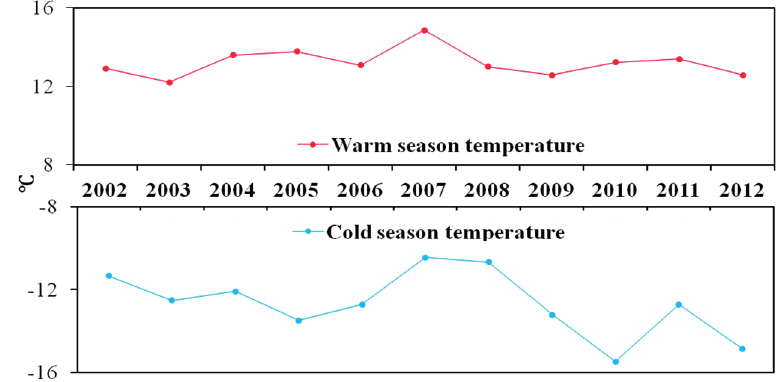
Figure 4. Temperature trend over study area from 2002 to